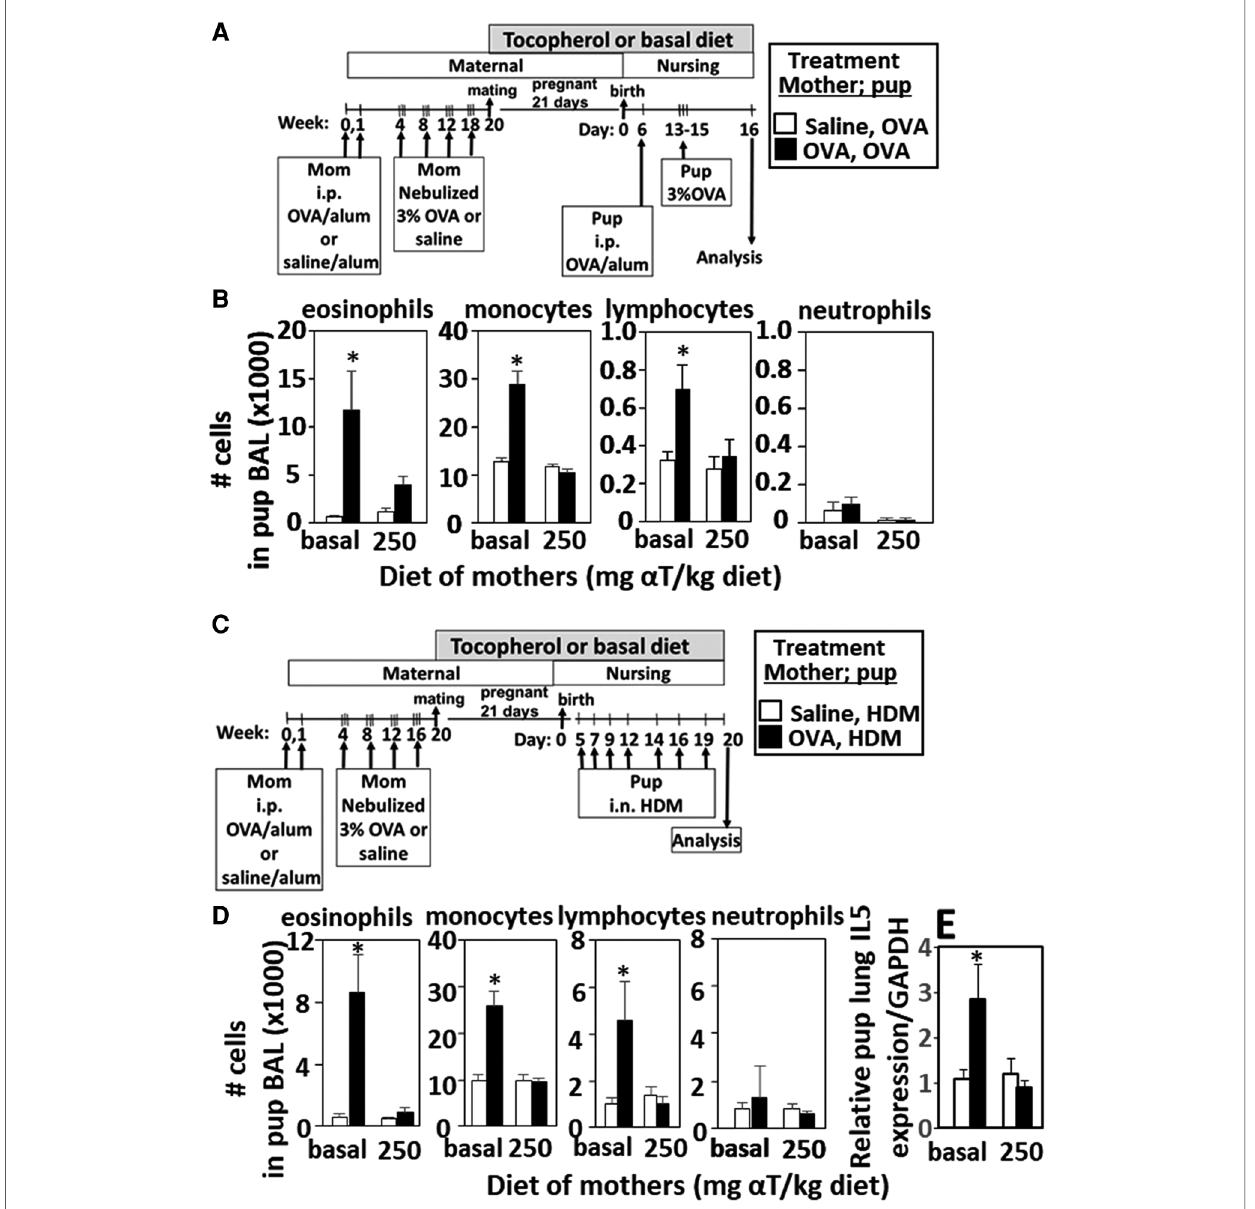
FIGURE 1 Enhanced responsiveness to challenge with HDM or OVA by pups of mothers with allergy was inhibited by maternal supplementation with α -tocopherol. The allergen of the mother and offspring can differ. ( A,C ) Allergic and non-allergic mothers received basal diet or diet supplemented with α T (250 mg α T/ kg of diet) during pregnancy and nursing. Timeline for allergen-sensitization and allergen-challenge of mothers and offspring. ( B,D ) Pup BAL eosinophils, monocytes, lymphocytes and neutrophils. ( E ) Relative IL-5 mRNA expression in lungs of HDM-challenged pups of allergic and non-allergic mothers with basal or α T-supplemented diets. BAL, bronchoalveolar lavage. n =8 – 10 mice/group. Saline treated pups did not have allergic in fl ammation (data not shown). * p